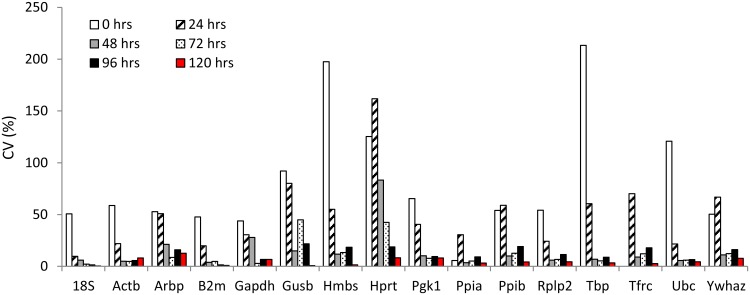
Coefficient of variation (%) ΔCt(GOI-RG) at different time points of cultivation.Data are based on at least 6 independent experiments.